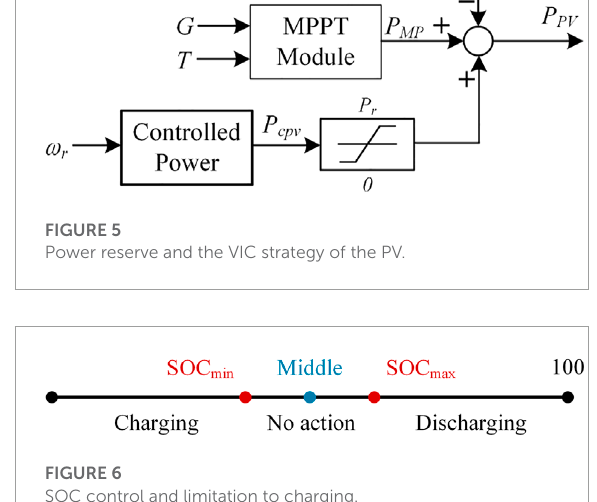
FIGURE 6 SOC control and limitation to